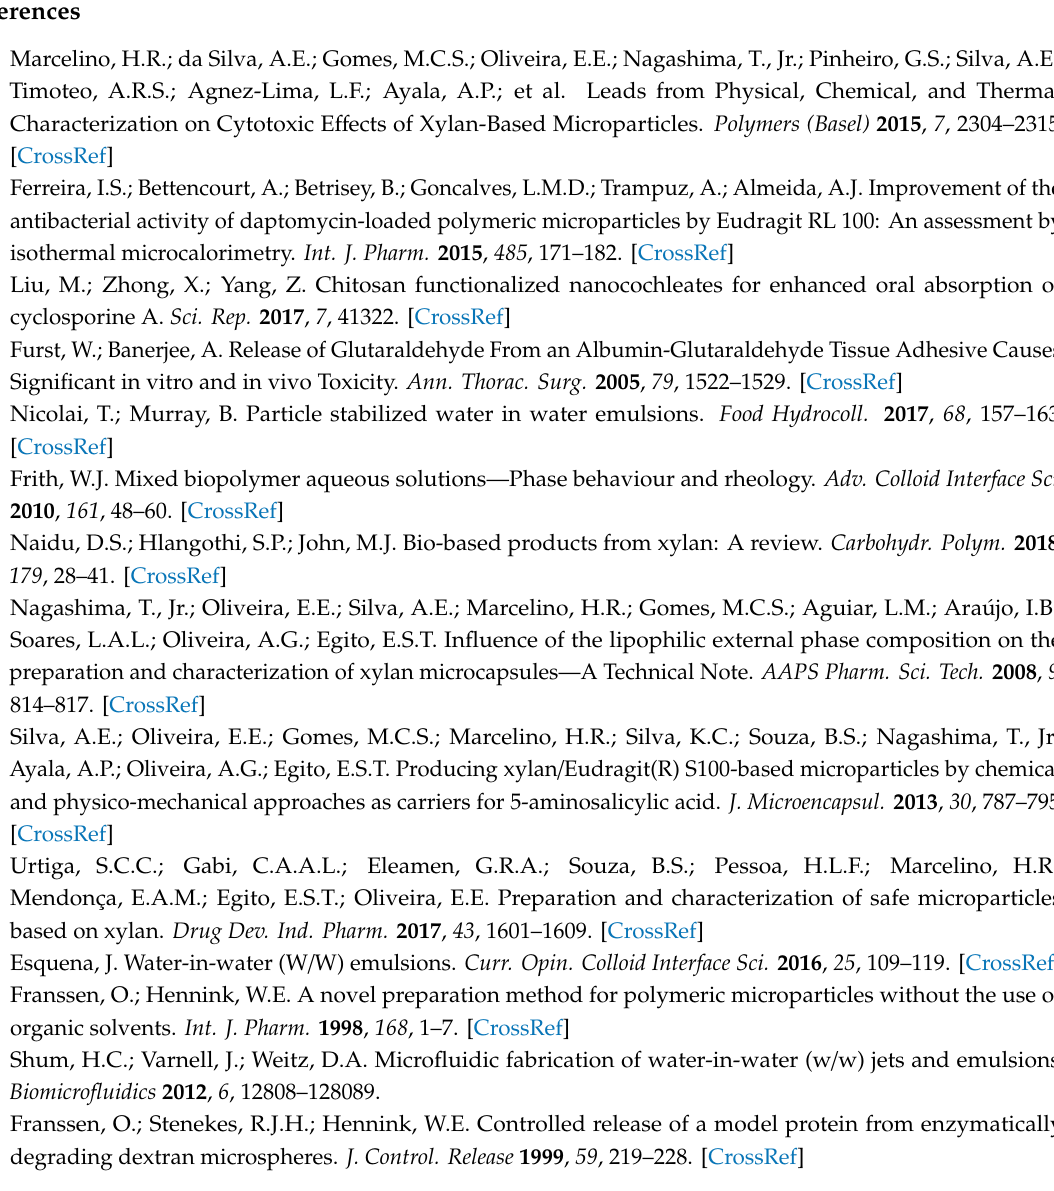
Table S1: Mathematical modeling of the experimental data, their equations and statistical